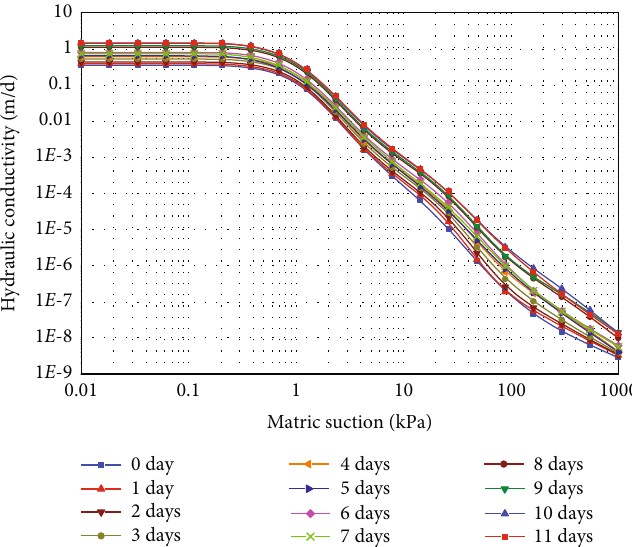
Figure 13: Unsaturated hydraulic conductivity functions of soil samples after di ff erent days of